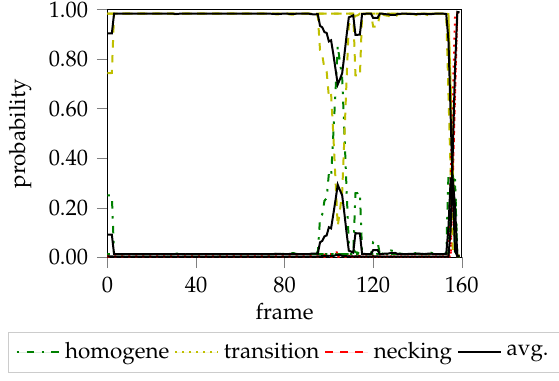
Figure 10. Probability progression of